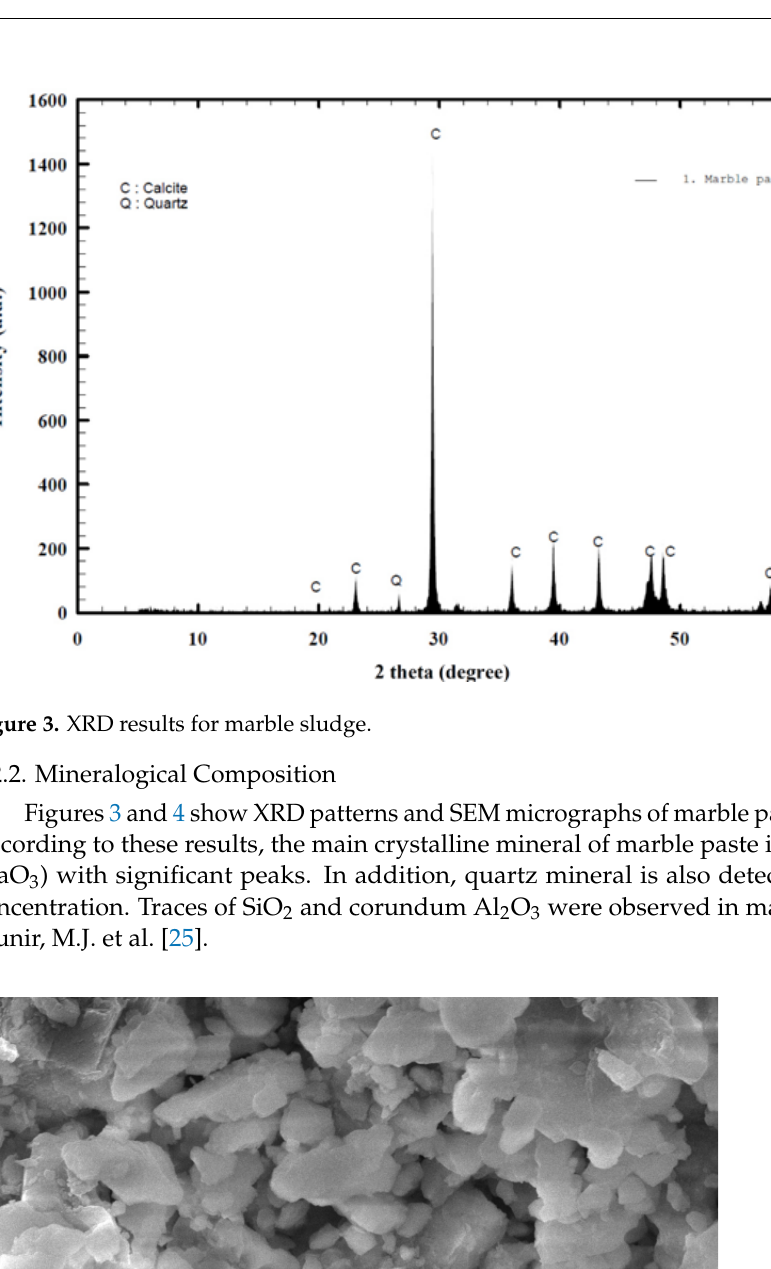
Figure 4. SEM micrographs of marble sludge.